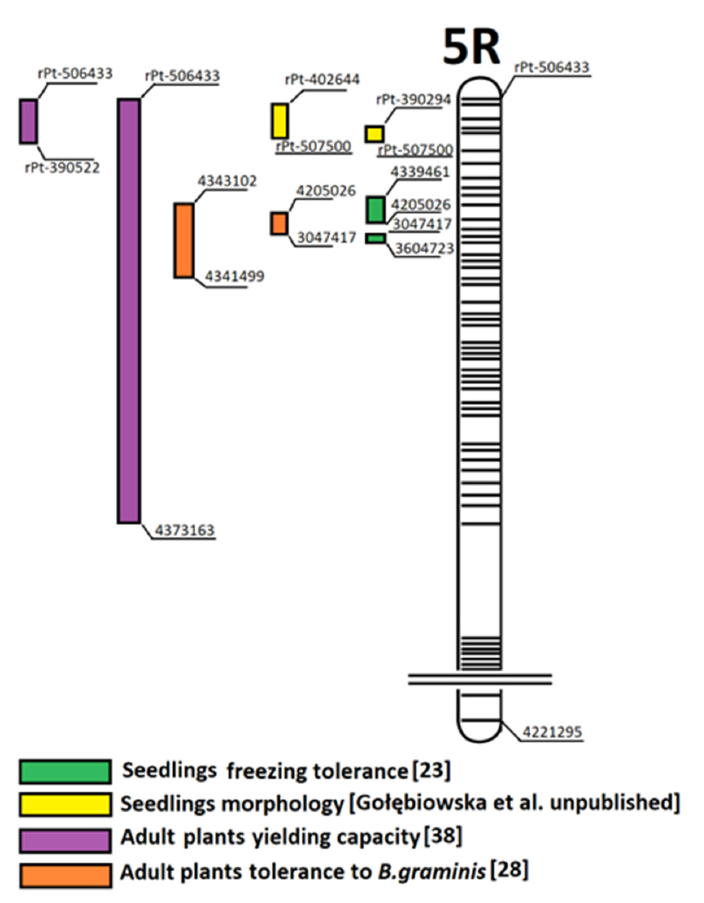
Figure 4. The 5R rye chromosome region containing regions determined here on the basis of experimental and bioinformatic studies, related to the freezing tolerance of winter triticale seedlings and their morphology parameters as well as the tolerance of adult plants to powdery mildew in the field and the yielding capacity in the generative phase.